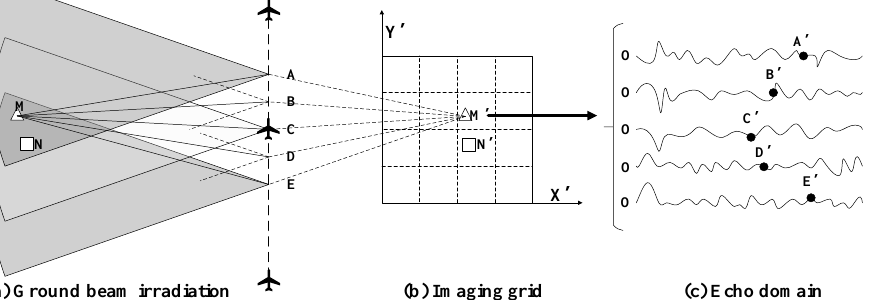
Figure 2. Working principle of the back-projection (BP) algorithm.